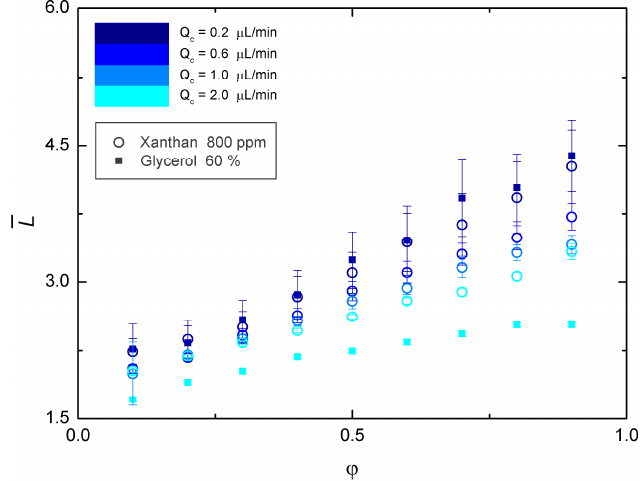
Figure 5. Dimensionless droplet length as a function of the flow rate ratio for the xanthan 800 ppm solution at constant Q c (empty circles) . As a comparison, we have also plotted the data of the Newtonian solution 60% ( w / w ) glycerol/water (full